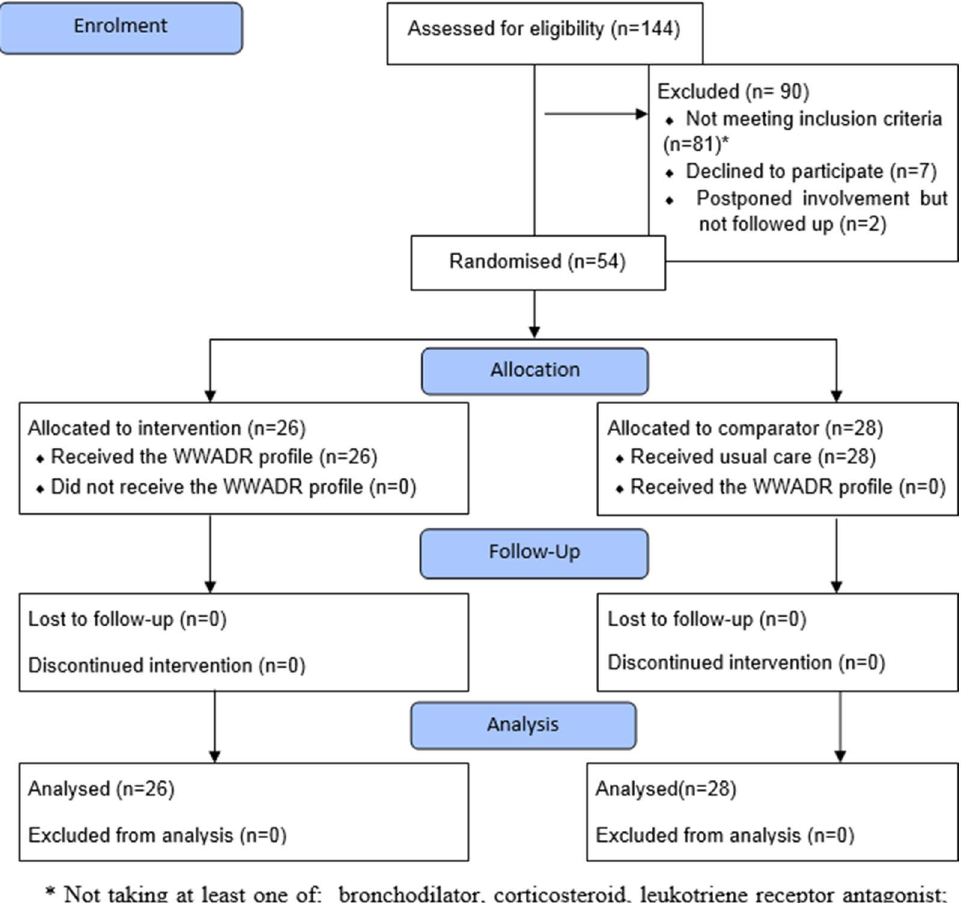
Figure 1. Flow of participants through the trial.